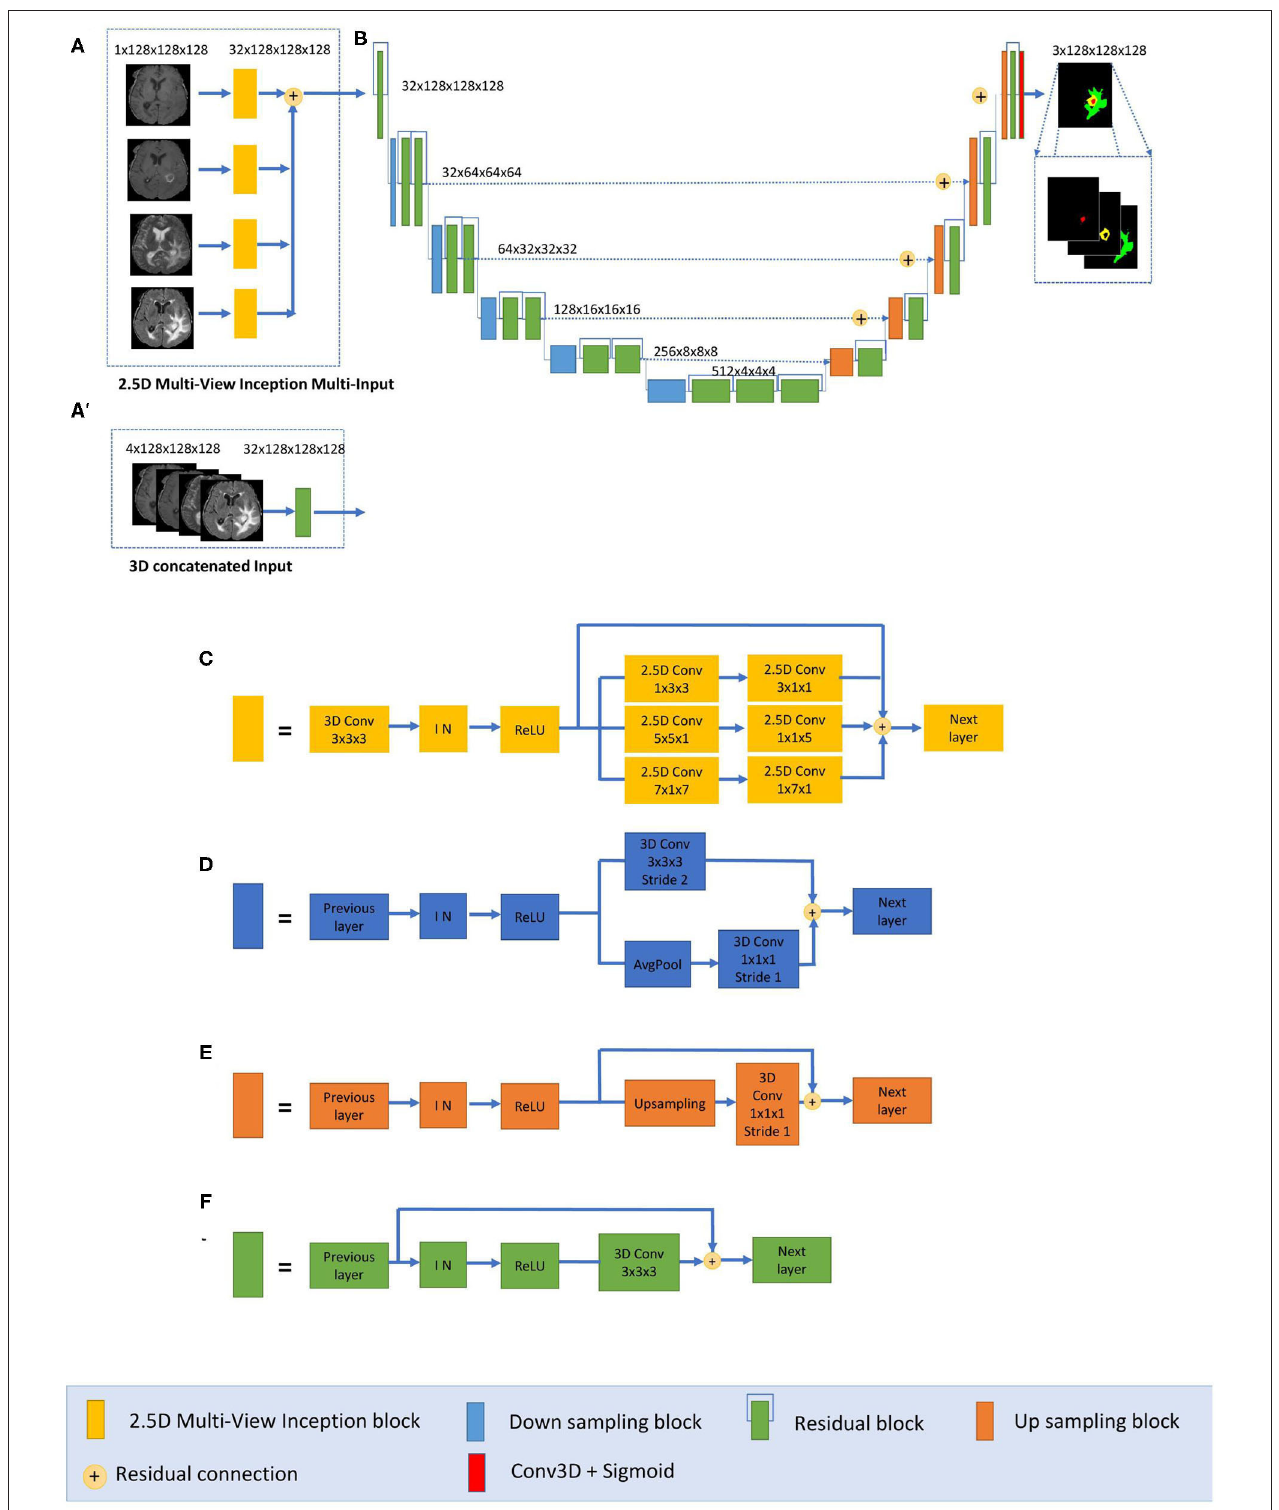
FIGURE 1 | Proposed 2.5D Asymmetric U-Net and 3D Asymmetric U-Net. (A) 2.5D Multi-View Inception Multi-input. (A ′ ) 3D concatenated input. (B) An asymmetric 3D U-Net architecture using residual blocks, instance normalization (IN), and additive skip connections between encoding and decoding sections. (C) 2.5D Multi-View Inception block. (D) Down sampling block. (E) Up sampling block. (F) Residual block.